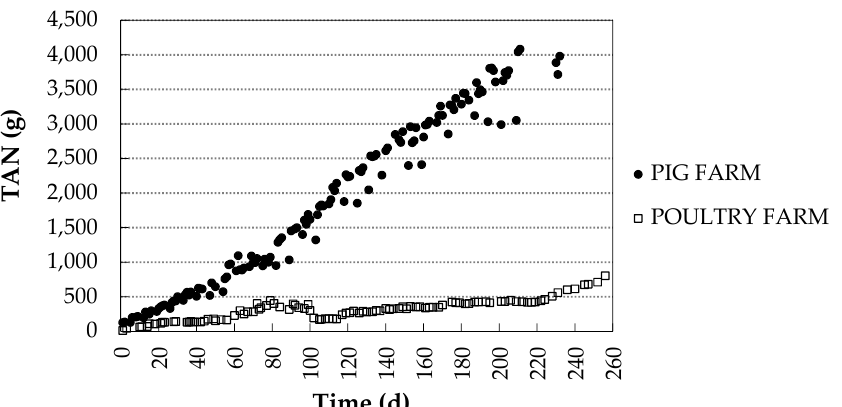
Figure 6. Evolution of the amount of TAN captured in the acidic solution during the experimental period in each farm.